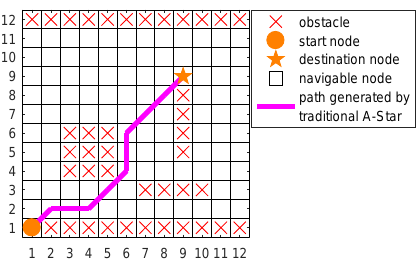
Figure 1. The grid map and path generated by the traditional